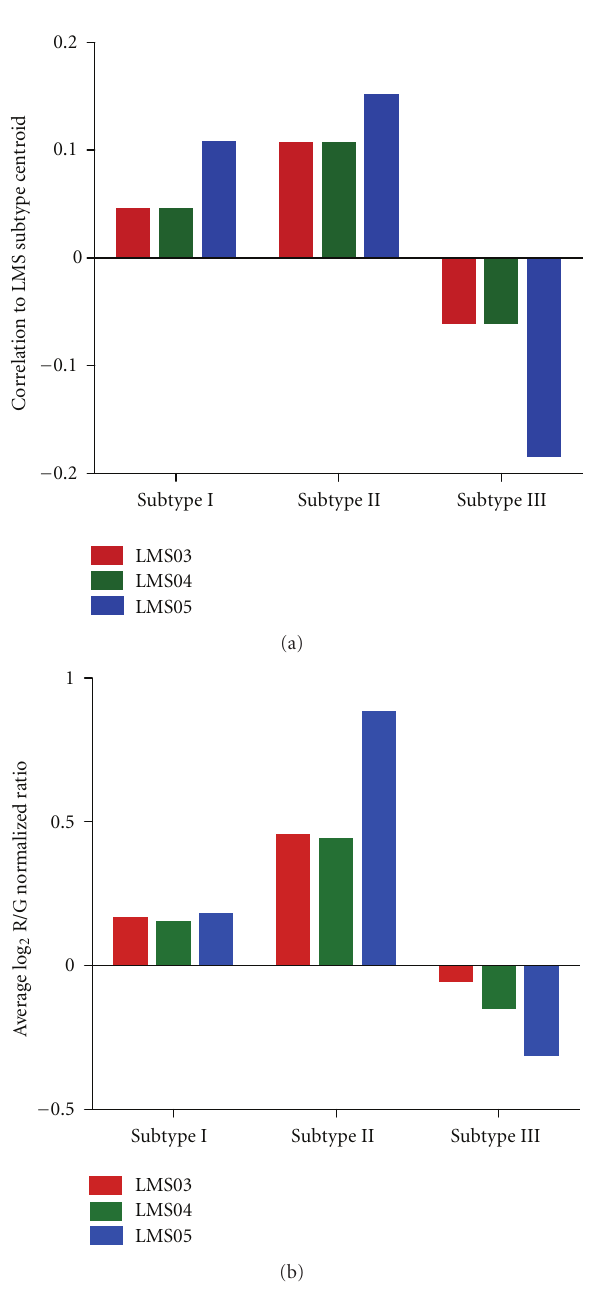
Figure 3: Subtype specificity of LMS cell lines. The correlations of LMS03, LMS04, and LMS05 cell lines to the centroids of the three LMS subtypes were assessed by nearest centroid analysis (a). The average expression levels of LMS subtype I, II, and III genes were evaluated in the three LMS cell lines to identify which LMS subtype these cell lines most closely resembled